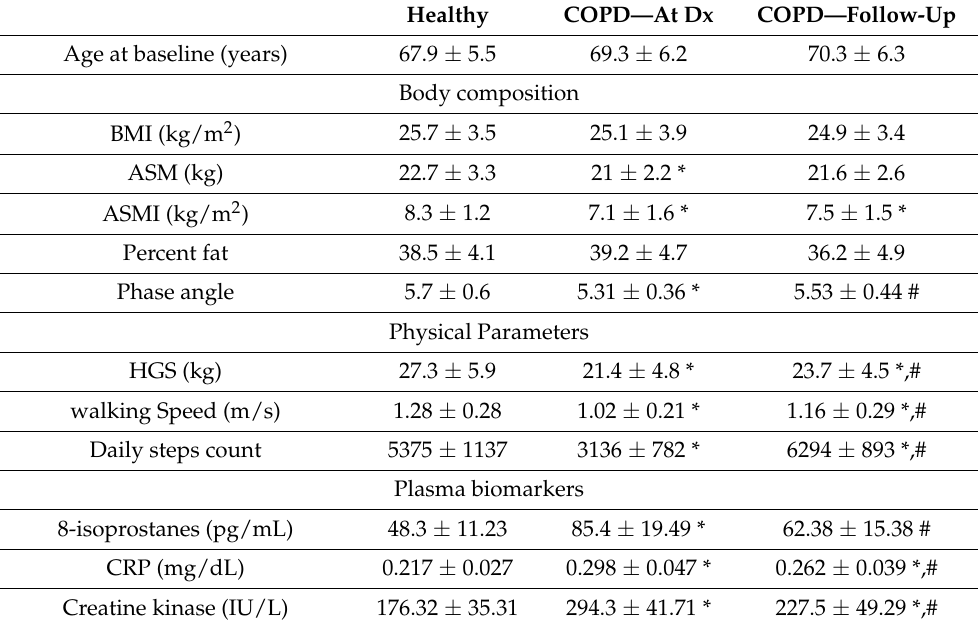
Table 1. Body composition and physical parameters of healthy controls and patients with COPD at diagnosis (Dx) and follow-up. Values are expressed as mean ± SD, one-way analysis of variance. * p < 0.05 vs. healthy controls; # p < 0.05 vs. COPD patients at diagnosis (Dx) ( n = 77–84 per group). Healthy COPD—At Dx COPD—Follow-Up Age at baseline (years) 67.9 ±